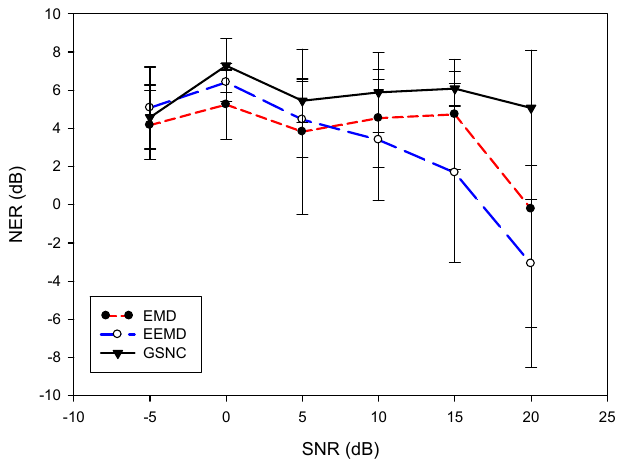
Figure 6. Comparison of overall average NER dB with various SNR for the proposed GSNC, EMD and EEMD schemes (PLn).